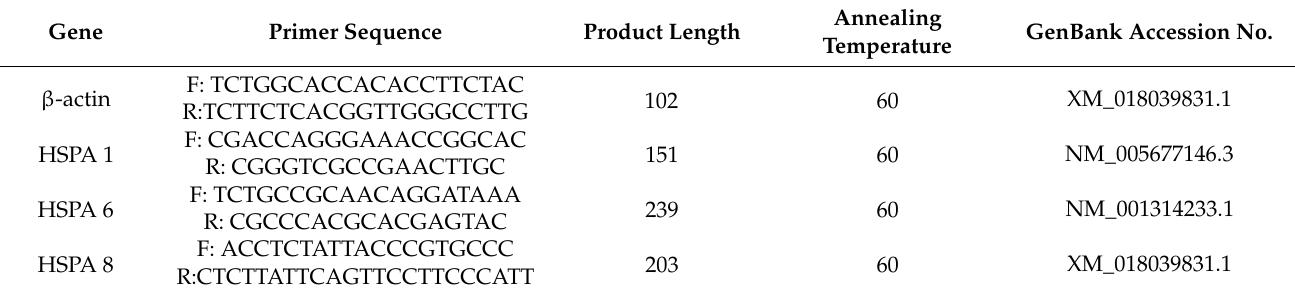
Table 2. Details of the primer